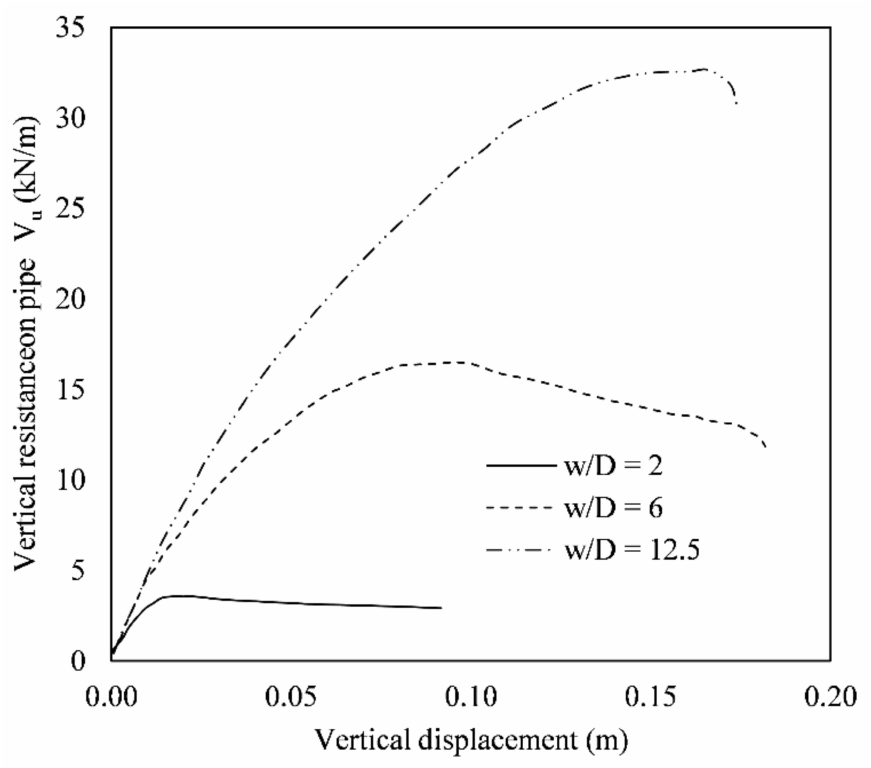
Figure 12. Variation of uplift resistance with displacement for various embedment depths [77].